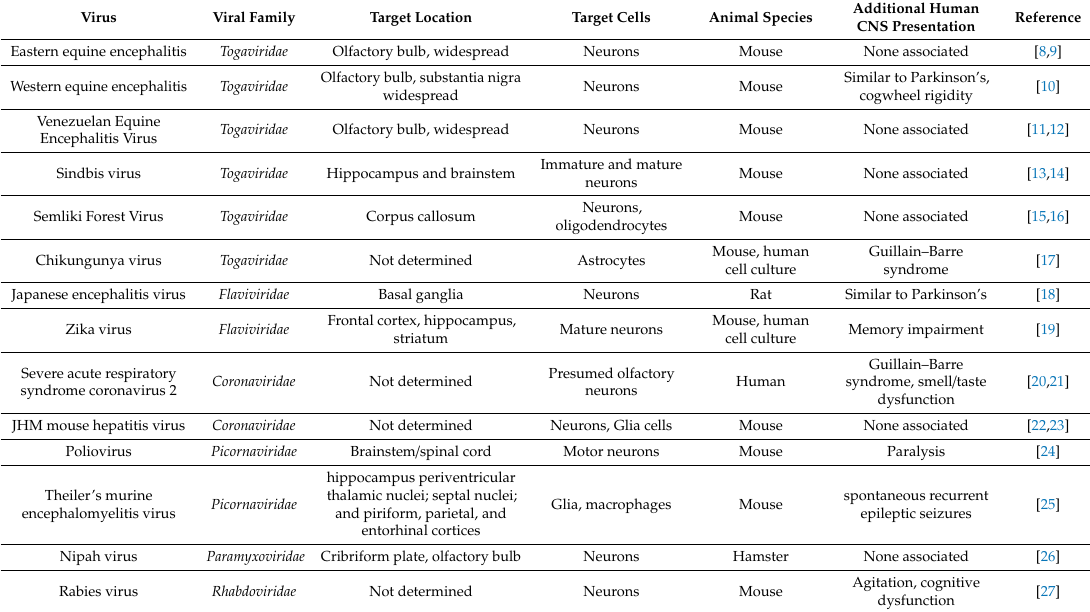
Table of select viruses known to induce encephalomyelitis including known target cells, regions, and unique presentations associated with infection. General meningoencephalomyelitis symptoms include but are not